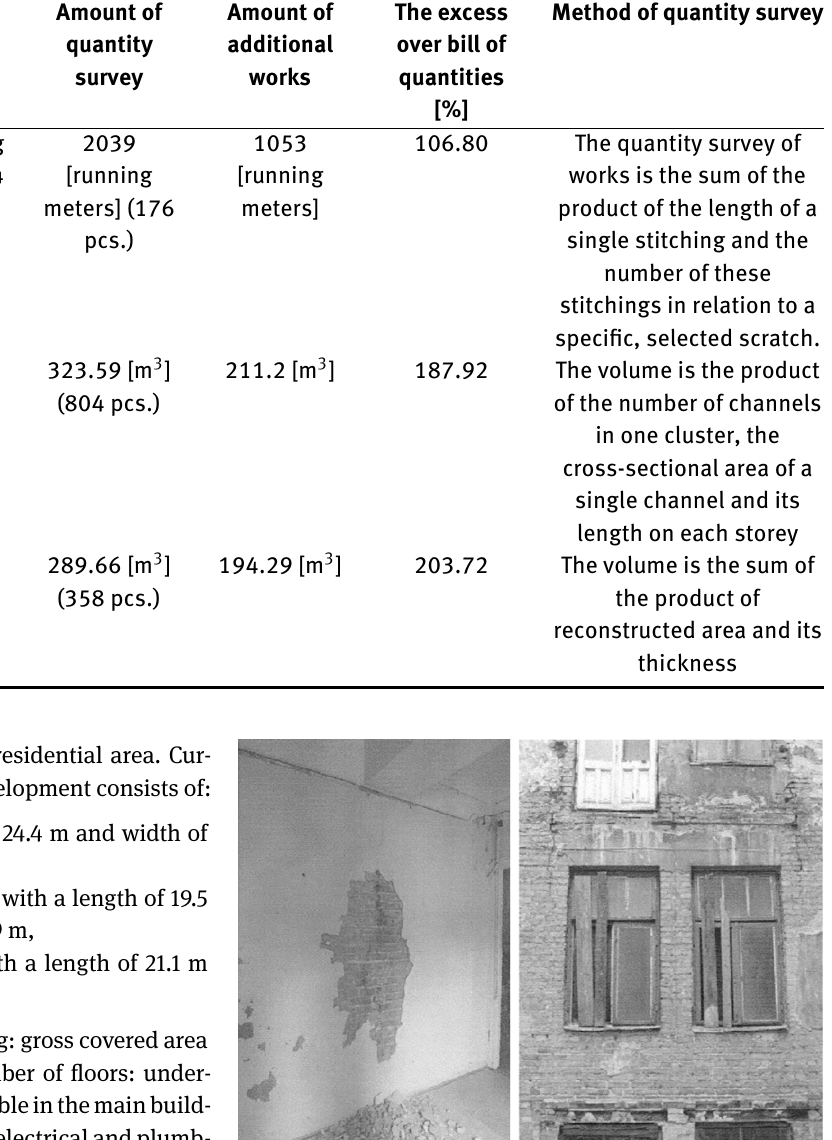
Amount of quantity survey